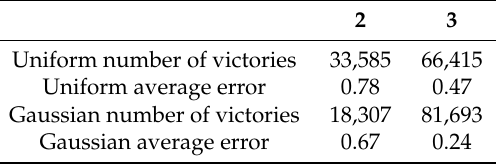
Table 7. k = 2 vs. 3 with rounding